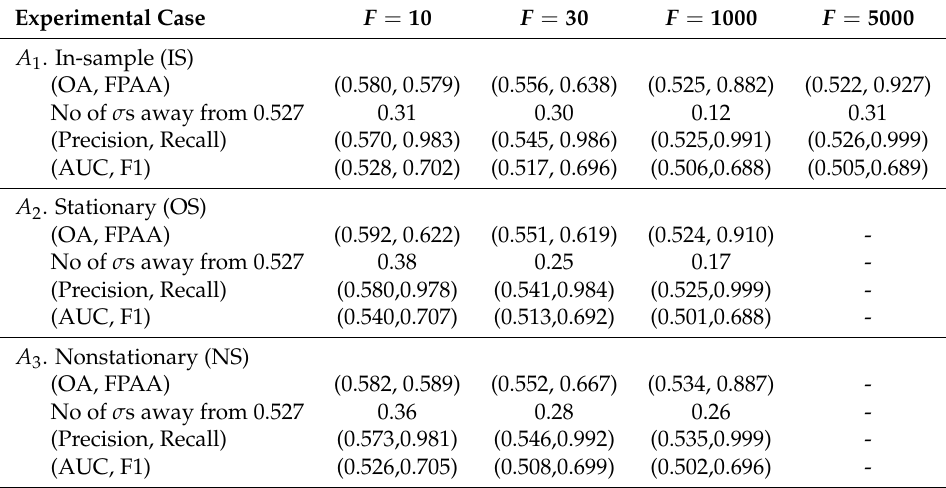
Table 1. Accuracy levels for three cases of experiments on stock market predictability. We report the overall accuracy (OA) and forecast period average accuracy (FPAA). The first number in each cell is the OA and the second number is the FPAA, computed at a threshold of 50%, i.e., FPAA = 1 if the percentage of correct forecasts in the prediction period ( F ) is greater than 0.5, else FPAA = 0. We may also compute FPAA for a threshold of 0.527, i.e., the baseline percentage of times the stock market rises, but we get identical results for F = 10,30 and slightly lower values for F = 1000. We also report how far from the threshold of 0.527 (in standard deviations) the OA is. In no case, is the predictive power significant. In addition, standard metrics such as precision, recall, AUC, and F1 scores are